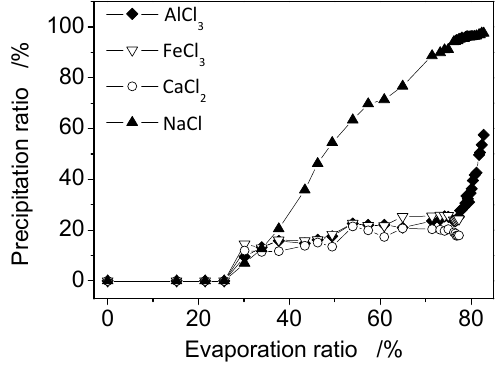
Figure 3. The precipitation sequence of crystal salts.